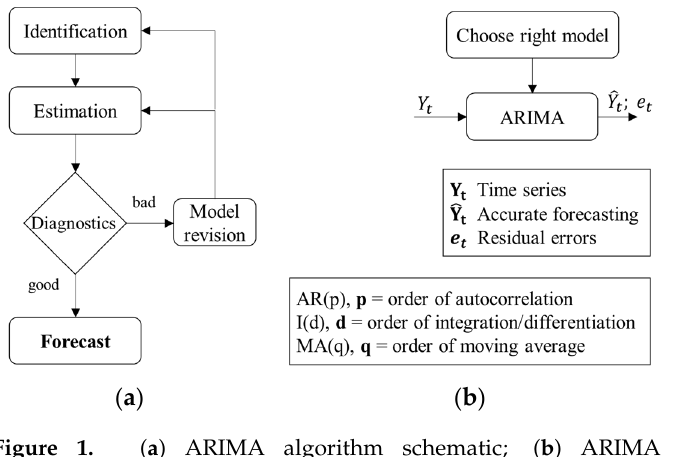
Figure 1. ( a ) ARIMA algorithm schematic; ( b ) ARIMA model assumptions where Y t = f ( Y t − k , e t − k ) + e t and k >